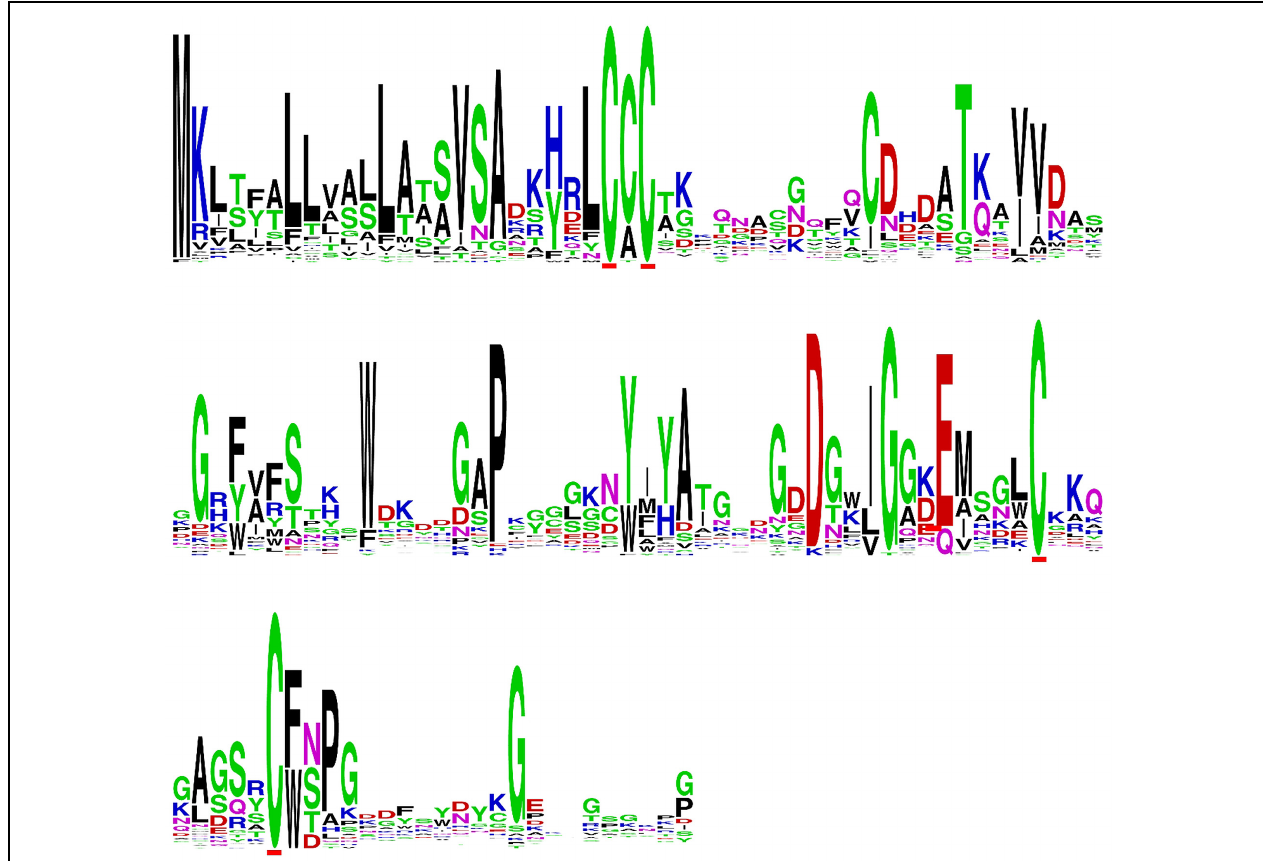
FIGURE 2 | Sequence logo of a multiple sequence alignment of predicted protein sequences including AvrLm6 and a paralogue from Leptosphaeria maculans (GenBank:CAJ90695 and XP_003843096.1) homologs from Colletotrichum gloeosporioides (GenBank:XP_007281214 and XP_007275717.1), Fusarium oxysporum (GenBank:EXK76127.1), C. higginsianum (GenBank:CCF39162.1), C. fiorinae (GenBank:XP_007599415.1) as well as ALVI_1 to ALVi_24 from Venturia inaequalis Vi1 and ALVp_1 to ALVp_16 from V. pirina isolate